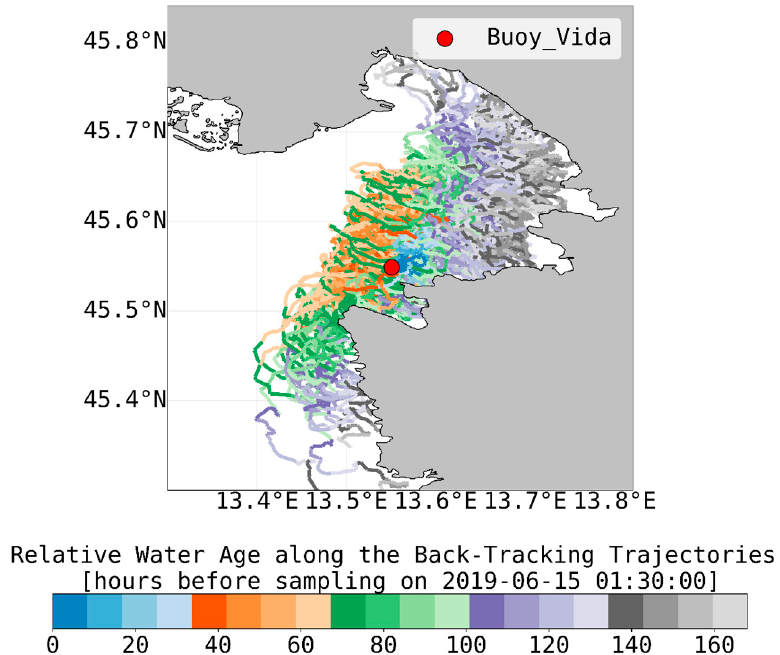
Figure 5. Trajectories (back-propagation) of water particles prior to reaching the buoy Vida location on 15 June at 02:30 UTC, color-coded by the relative water age.